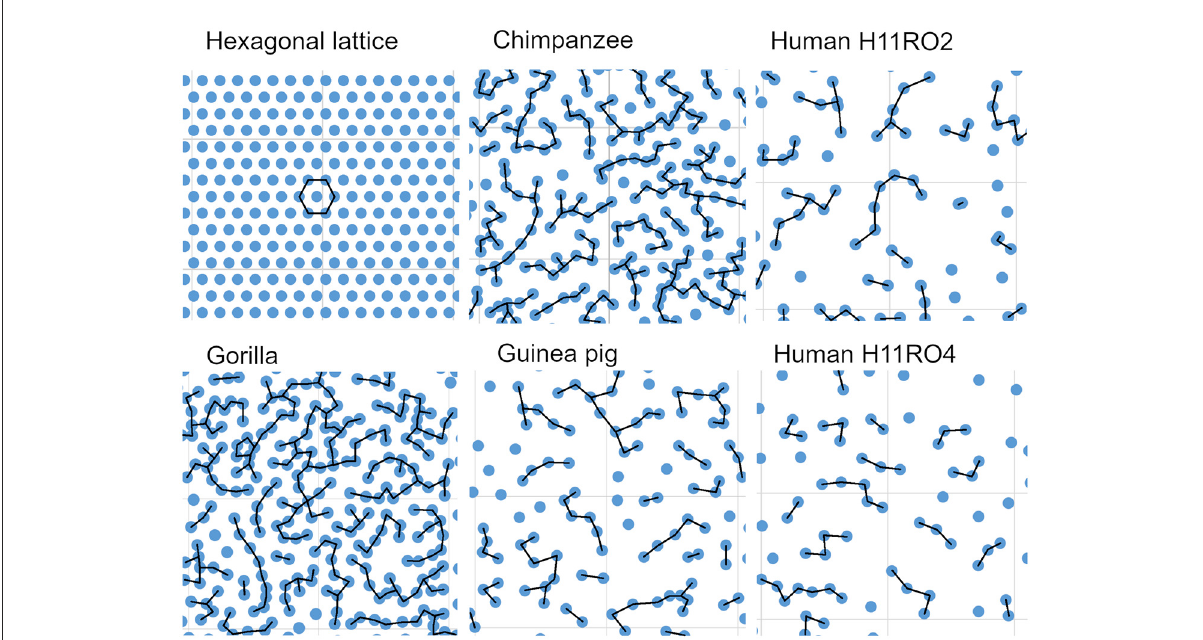
FIGURE10 Comparison of an imaginary hexagonal lattice, with the arrangement of myelin bundles from representative areas from the five sections that were digitally reconstructed. In each case a bundle is represented by a blue circle (diameter 17 µ m). In the hexagonal lattice each “bundle” is equidistant from its six nearest neighbors (26.67 µ m) while in the cortex the bundles form branched strings of closely adjacent bundles the centers of which are usually < 27 µ m apart from their nearest neighbor (as indicated by the black lines). Each panel has a background lattice with a thin gray line indicating squares with a side of 200 µ